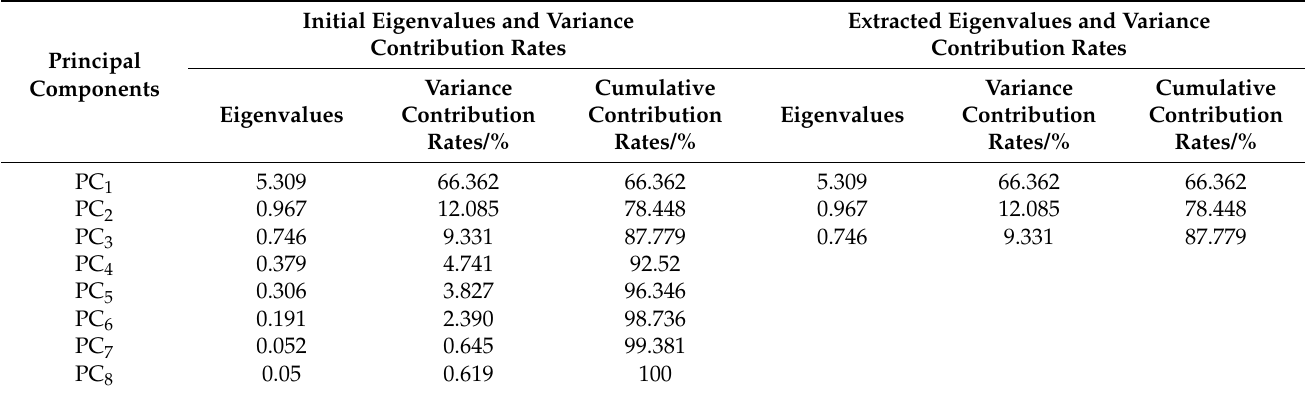
Table 3. Eigenvalues and variance contribution rates of the